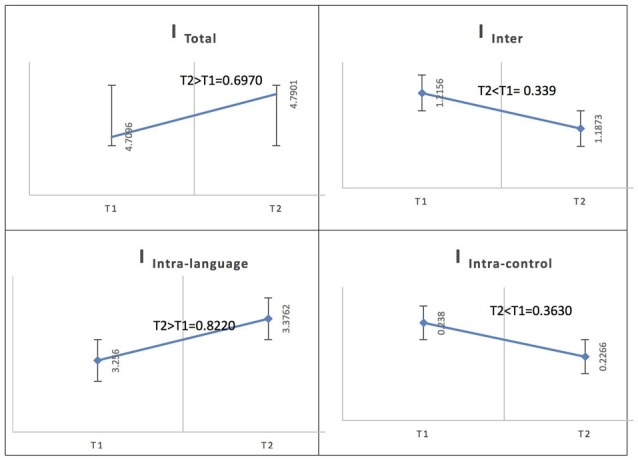
Probability value of the network integration differences across phases for L2 (French) in the Spanish-speaking group (L1 = Spanish). I = integration, ITotal = total integration value, IIntra_Language = Intra-integration of language areas, IIntra_Control = Intra-integration of cognitive control areas and IInter = integration between the two networks (language processing and cognitive control). A probability greater than 0.9 is considered significant.